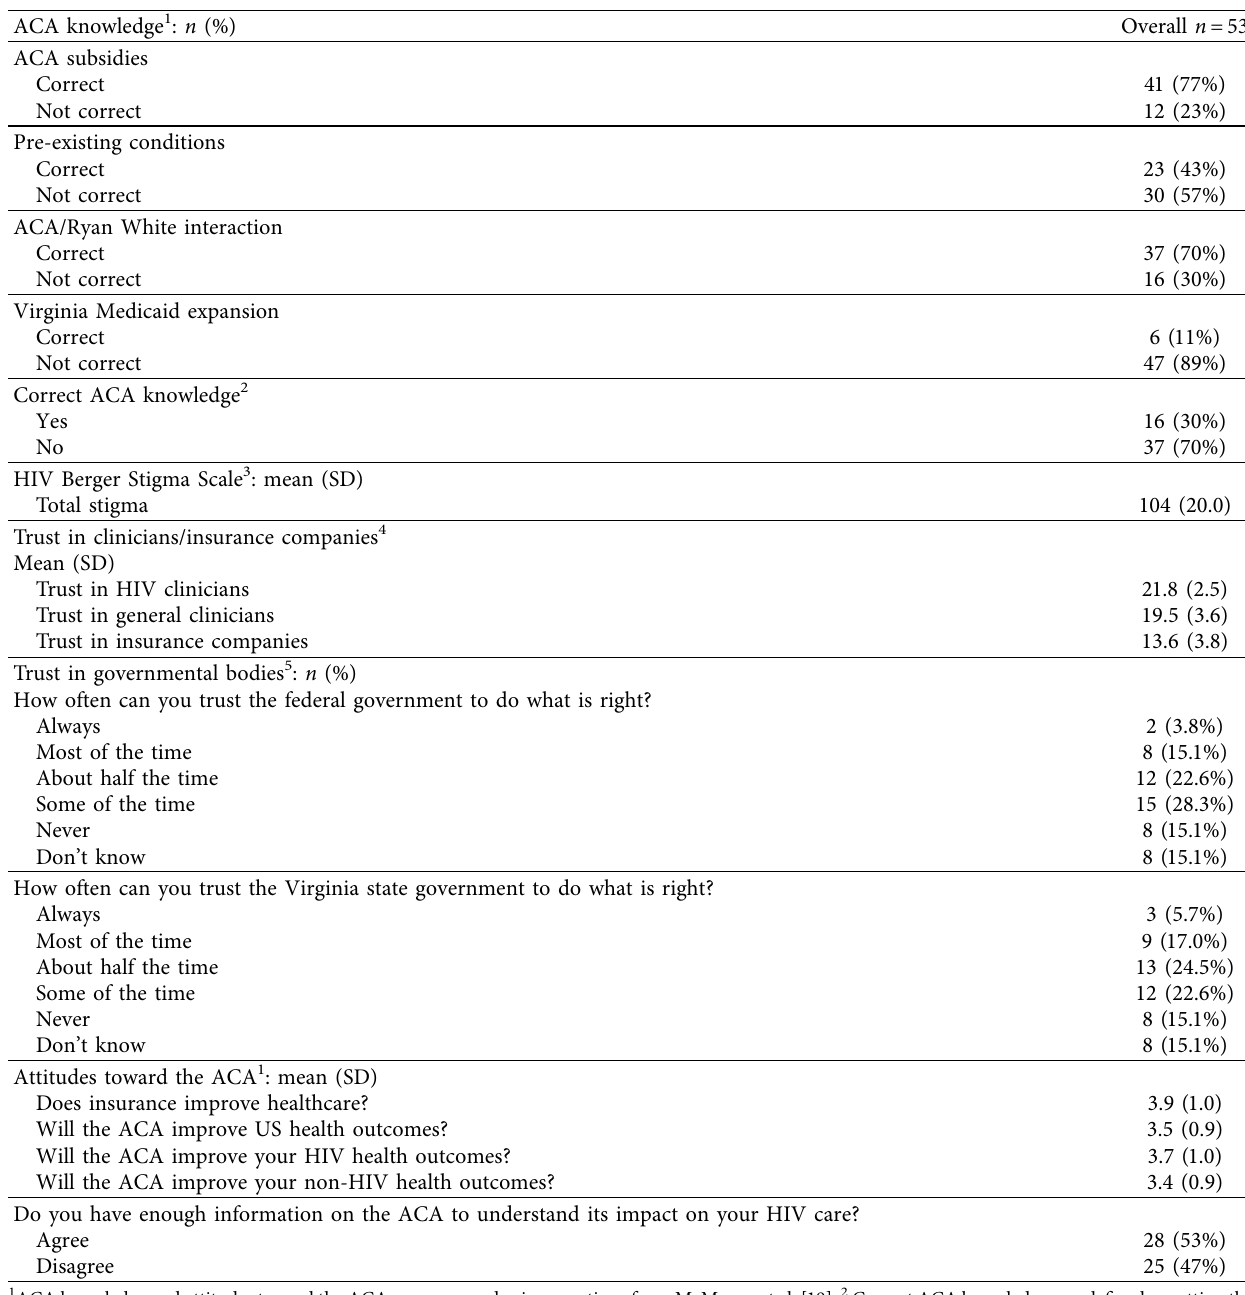
Table 2: Respondents’ Affordable Care Act (ACA) knowledge, HIV stigma, trust in the healthcare system and government, and ACA